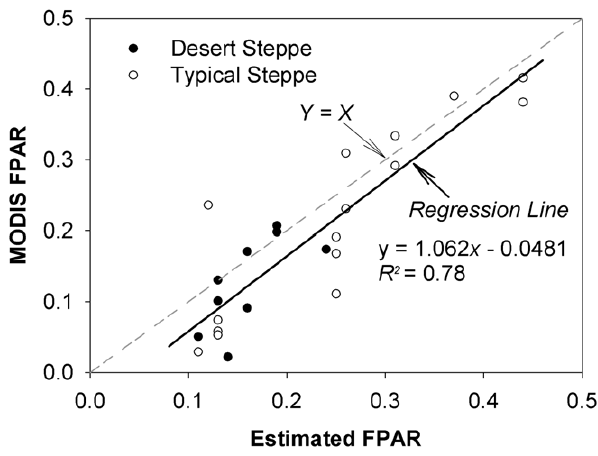
Figure 1. Relationship between insitu fraction of photosyn- thetically active radiation absorbed by plant canopy (FPAR) and MODIS FPAR. The in situ FPAR was estimated using Beer-Lambert Law, and LAI by destructive sampling